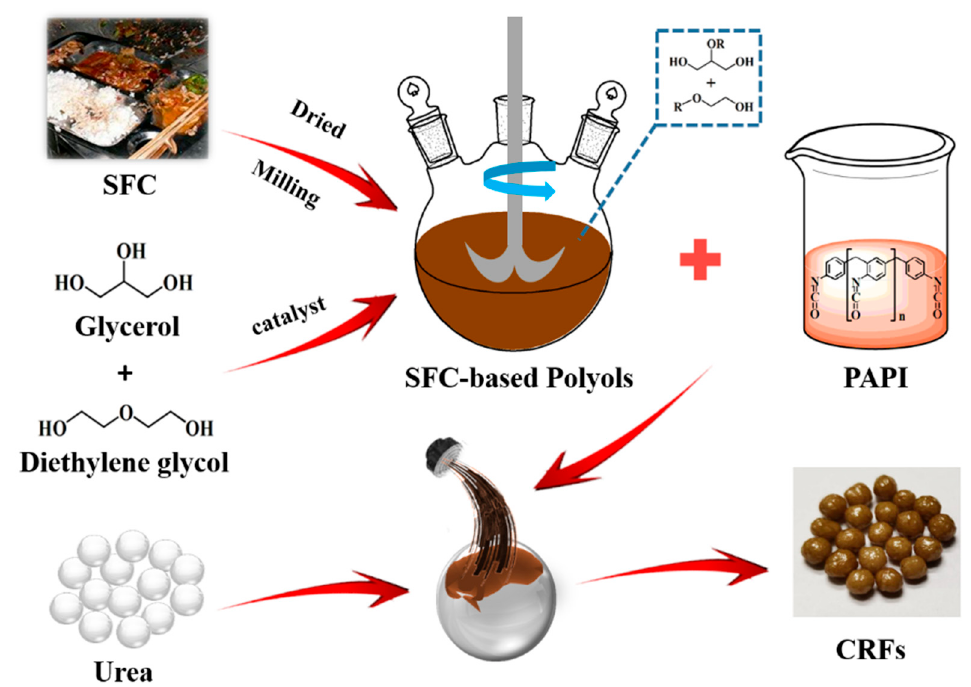
Scheme 1. Diagram of the fabrication process of the bio-based PU-coated